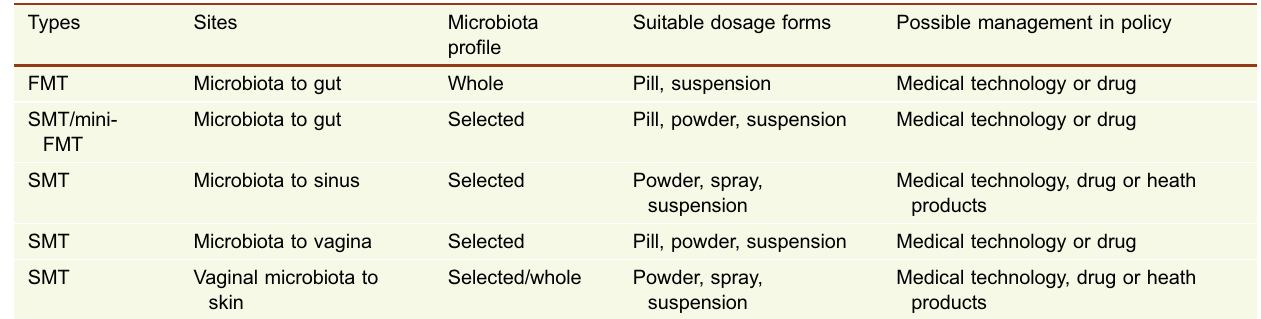
Table 2. Possible usage of microbiota transplantation in human